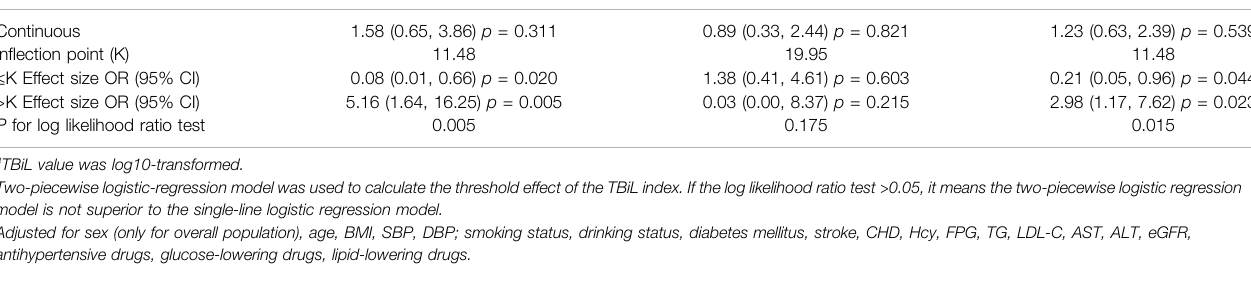
TABLE 3 | Results of two-piecewise logistic-regression model. TBiL a Male Female All Participants